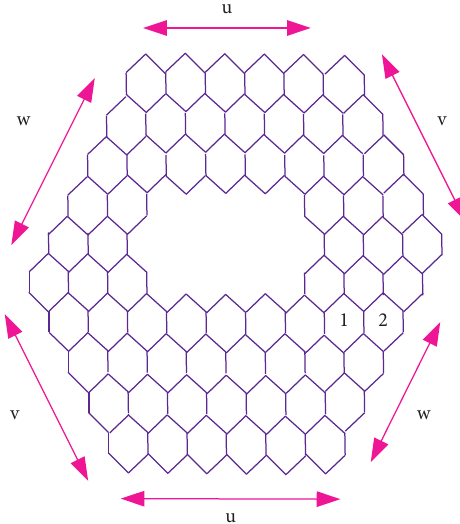
Figure 3: Coronoid system of C